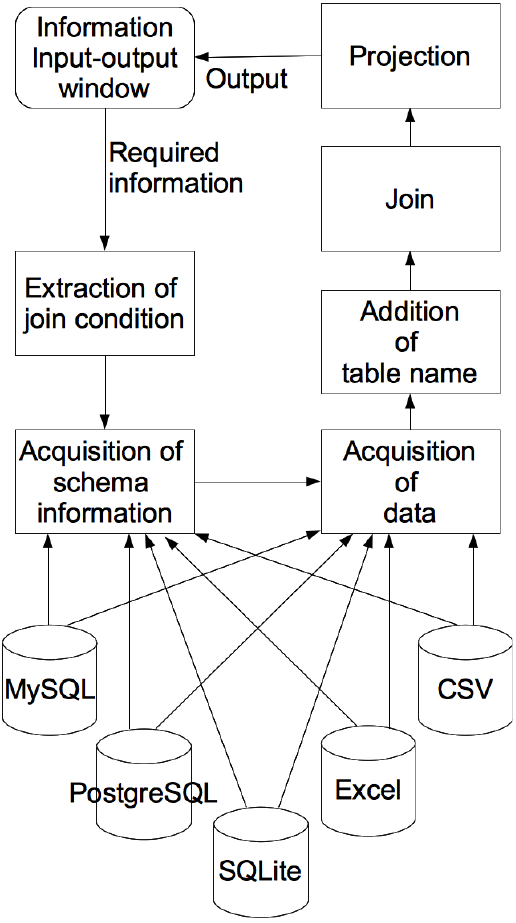
Fig. 2. Flow of join